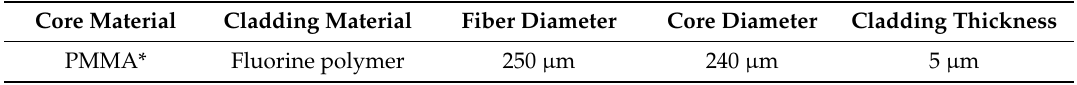
Table 1. Fiber parameters important for chemical etch CPC tip